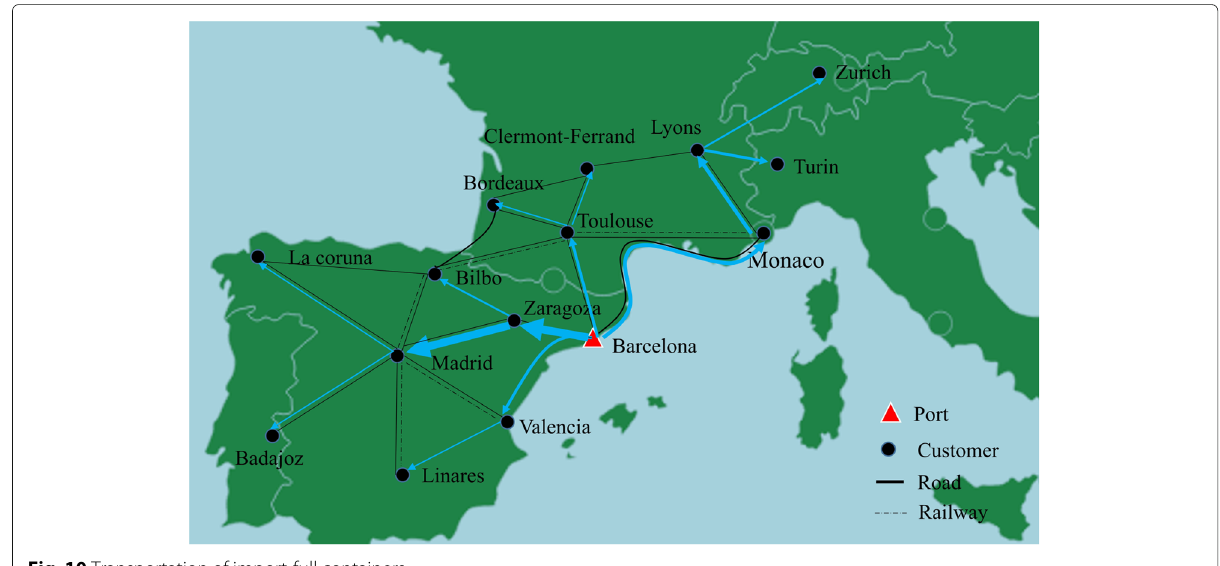
Fig. 10 Transportation of import-full containers (Dalian) since this paper considers the conversion of con- tainers. That is, full containers will convert to empty containers after discharging. Therefore, the inland depots collect the empty containers for the demand of exporting that they serve. Surplus empty containers are dispatched between depots owing to the gaps between the quantities of imports and exports, mostly adjacent depots, e.g., from Changchun to